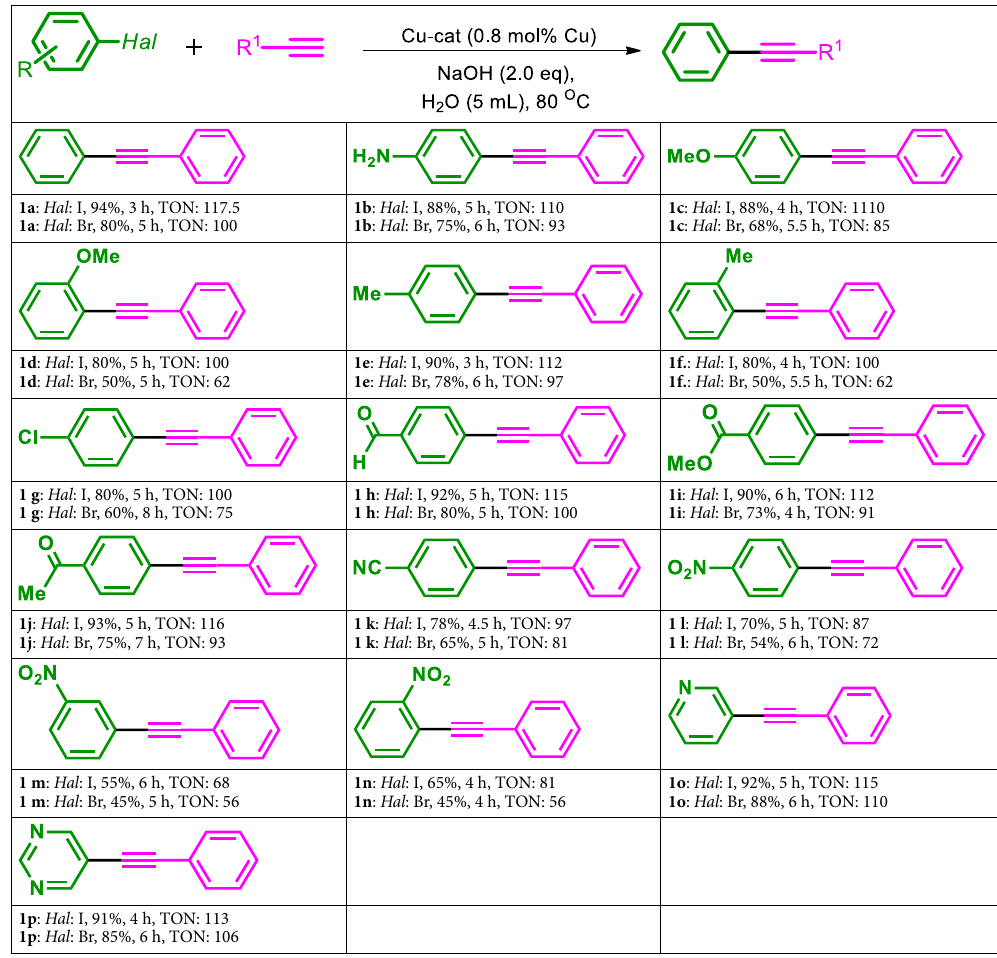
Table 2. Sonogashira coupling reactions of different aryl halides with phenylacetylene catalyzed by γ-Fe 2 O 3 @ PEG@PAMAM G 0 -Cu a . a Reaction conditions: aryl halide (1.00 mmol), acetylene (1.5 mmol), NaOH (2.00) mmol, catalyst (0.006 g, 0.8 mol% Cu), H 2 O (5.0 mL), 80 °C; All yields are isolated.